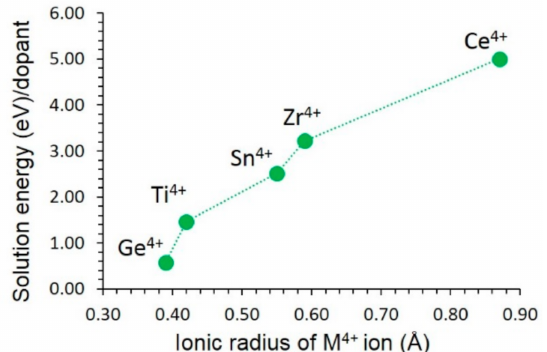
Figure 7. Solution energy of MO 2 with respect to the M 4+ ionic radius in Fe 3 Al 2 Si 3 O 12